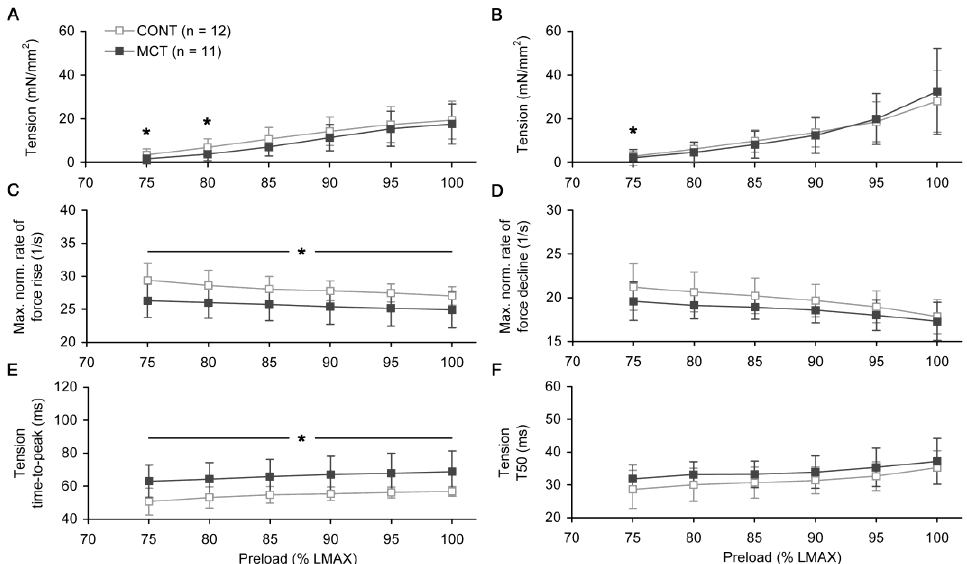
Figure 4. The preload-dependent changes in the mechanical characteristics of steady-state isometric twitch measured in the right atrial strips of control (CONT, n = 12) and monocrotaline-treated (MCT, n = 11) rats. ( A ) Tension–length relationship for peak active tension. ( B ) Tension–length relationship for passive tension. ( C ) Maximal normalized rate of force rise. ( D ) Maximal normalized rate of force decline. ( E ) Time-to-peak of isometric tension. ( F ) Relaxation time of isometric tension from the peak to 50% of its amplitude ( T 50 ). The legend in ( A ) is common for all panels. Data shown as mean ± S.D. *—the difference between CONT and MCT is significant at p < 0.05. All measurements were done at 30 °C and a 2 Hz pacing rate.